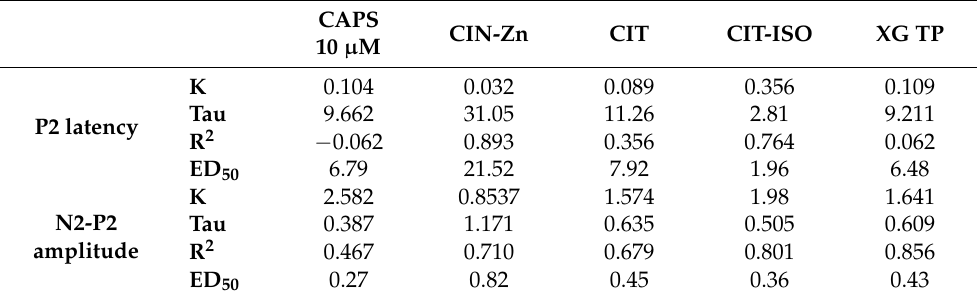
Table 3. Parameters of the one-phase decay curves for the proportion of patients with improved P2 peak latency and N2-P2 amplitude.